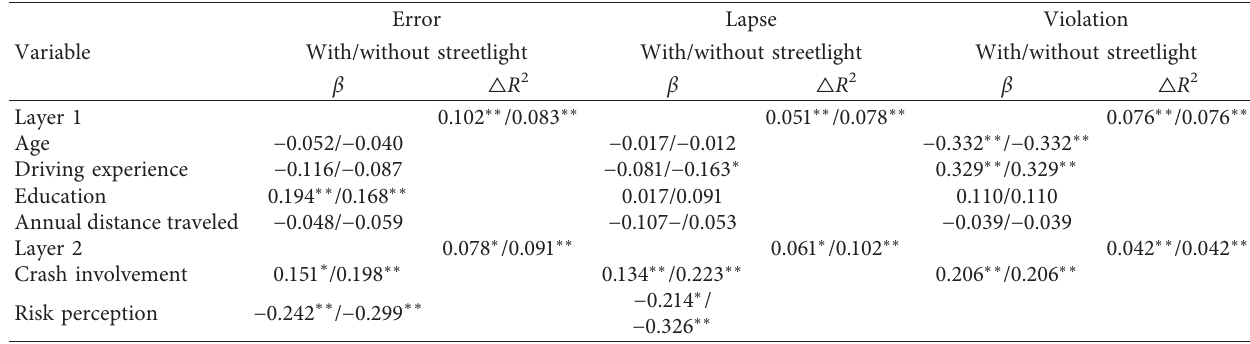
Table 10: Results of multiple linear regression